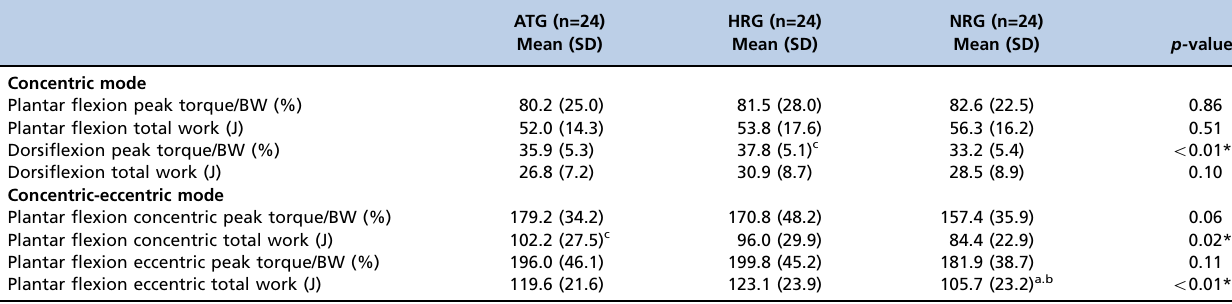
Table 3 - Test results for the hypothesis of equality of the means of isokinetic variables at 60 o /sec.